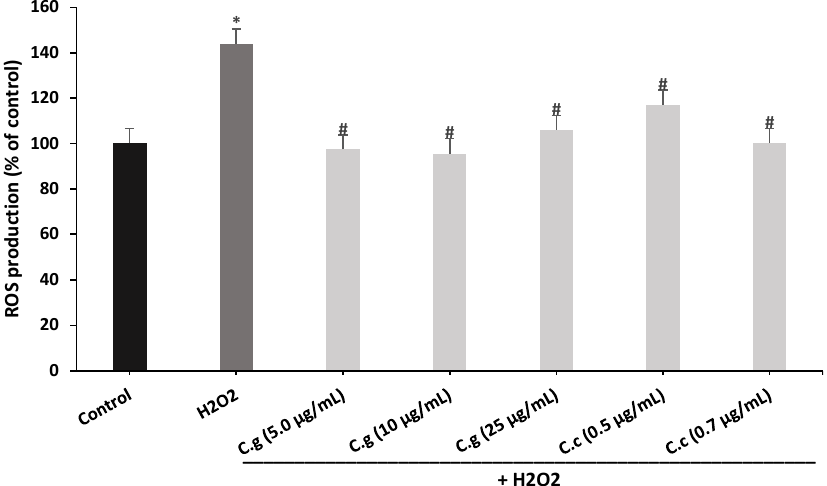
Figure 9. Effect of C. gracilis and C. chlorophaea extracts on cytoprotection in an H 2 O 2 -induced oxidative stress model. The values represent the means ± SD of three replicates (n = 3). Values marked with * and # are statistically different using the Tukey test at a 0.05 level of significance ( p < 0.05) versus the control and versus H 2 O 2 , respectively.